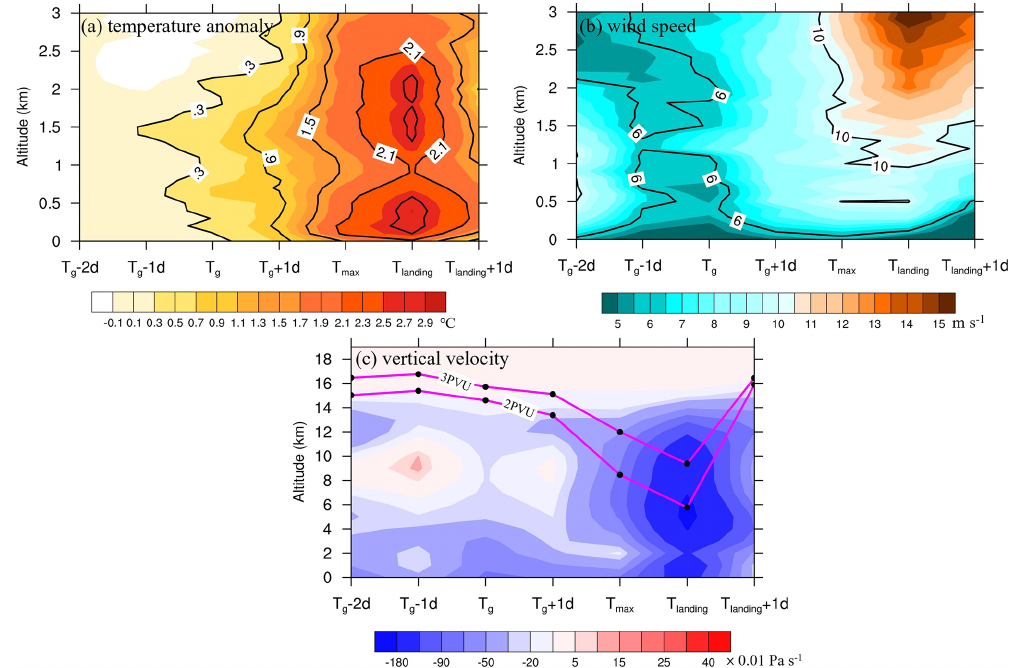
Figure 6. (a) Temperature anomalies relative to T g − 2d (in ◦ ) and (b) wind speed at each typhoon developmental stage within the boundary layer using the simultaneous flight observations at Taoyuan International Airport in Taiwan. (c) Vertical velocity (shaded; 0.01Pas − 1 ) and the average height of 2PVU (potential vorticity units, 1PVU = 10 − 6 m 2 s − 1 Kkg − 1 ) and 3PVU regions. The data are averaged over the large ensemble of typhoons for the 2014–2018